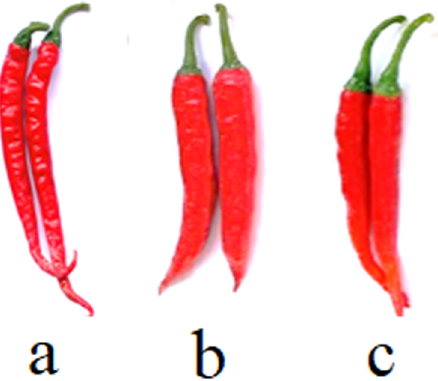
Figure 1: Fruit shape of UNPAD CB2 ( a ) , Tanjung 2 ( b ) , and Lingga variety ( c ) .